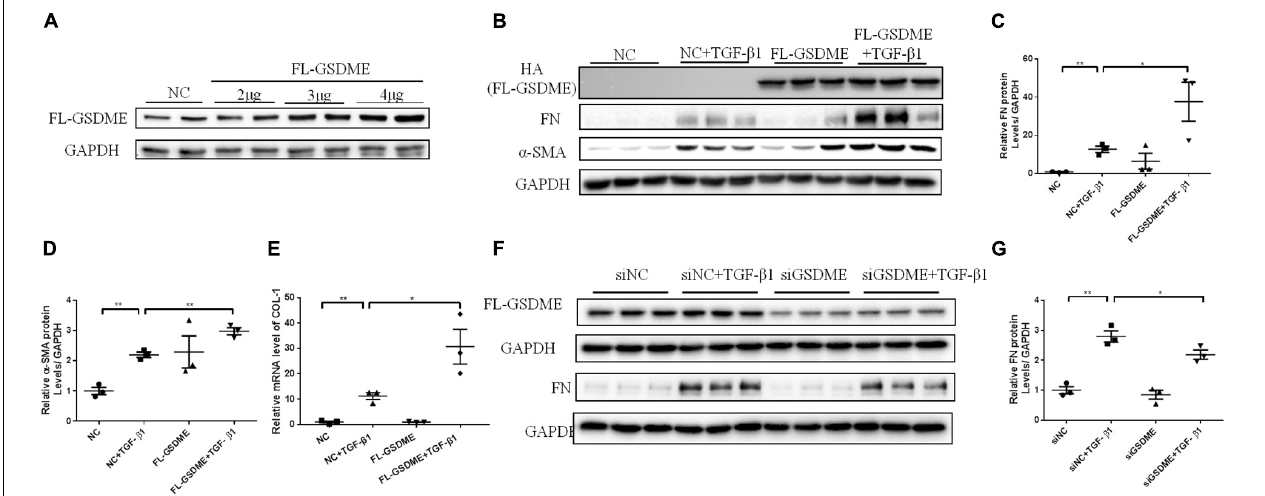
FIGURE 3 | Full Length Gasdermin E (FL-GSDME) promotes profibrotic response in TGF- β 1-treated HK-2 cells. HK-2 cells were treated with FL-GSDME overexpressing plasmid. (A) Transfection efficiency of FL-GSDME overexpressing plasmid at a dosage of 2, 3, and 4 µ g/mL detected by western blotting analysis. (B–D) Western blotting analysis of FN and α -SMA in cells transfected with FL-GSDME plasmids (3 µ g/mL) followed by treatment with TGF- β 1 (10 ng/mL). (E) qPCR analysis of COL-1 in cells transfected with FL-GSDME plasmids (3 µ g/ml) followed by treatment with TGF- β 1 (10 ng/mL). HK-2 cells were treated with GSDME siRNA. (F,G) Silencing efficiency of FL-GSDME siRNA transfection detected by western blotting analysis. Western blotting analysis of FN in cells transfected with GSDME siRNAs followed by treatment with TGF- β 1 (10 ng/mL). All the cell experiments, three independent experiments were performed. The quantitative results were shown as the means ± SEM. n = 3 in each group. * p < 0.05; ** p <